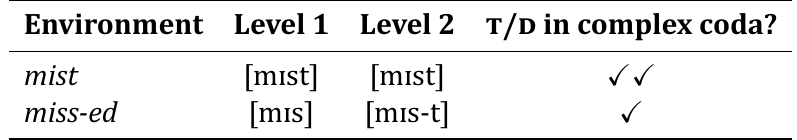
Table 3: Derivation of (cid:281)/(cid:265)-deletion, based on Guy